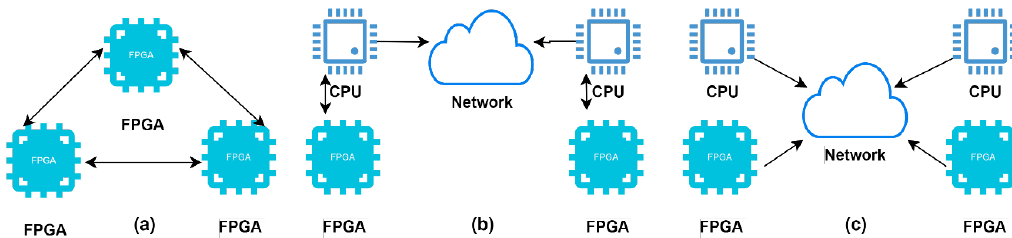
Figure 6. Multi-FPGA Architectures: ( a ) Direct Model represents FPGA to FPGA communication; ( b ) Slave Model represents FPGAs as special peripherals connected to Central Processing Units (CPUs) through PCIe; ( c ) Standalone Model represents accessible FPGAs, CPUs, or Graphical Processing Units (GPUs) through connected network.